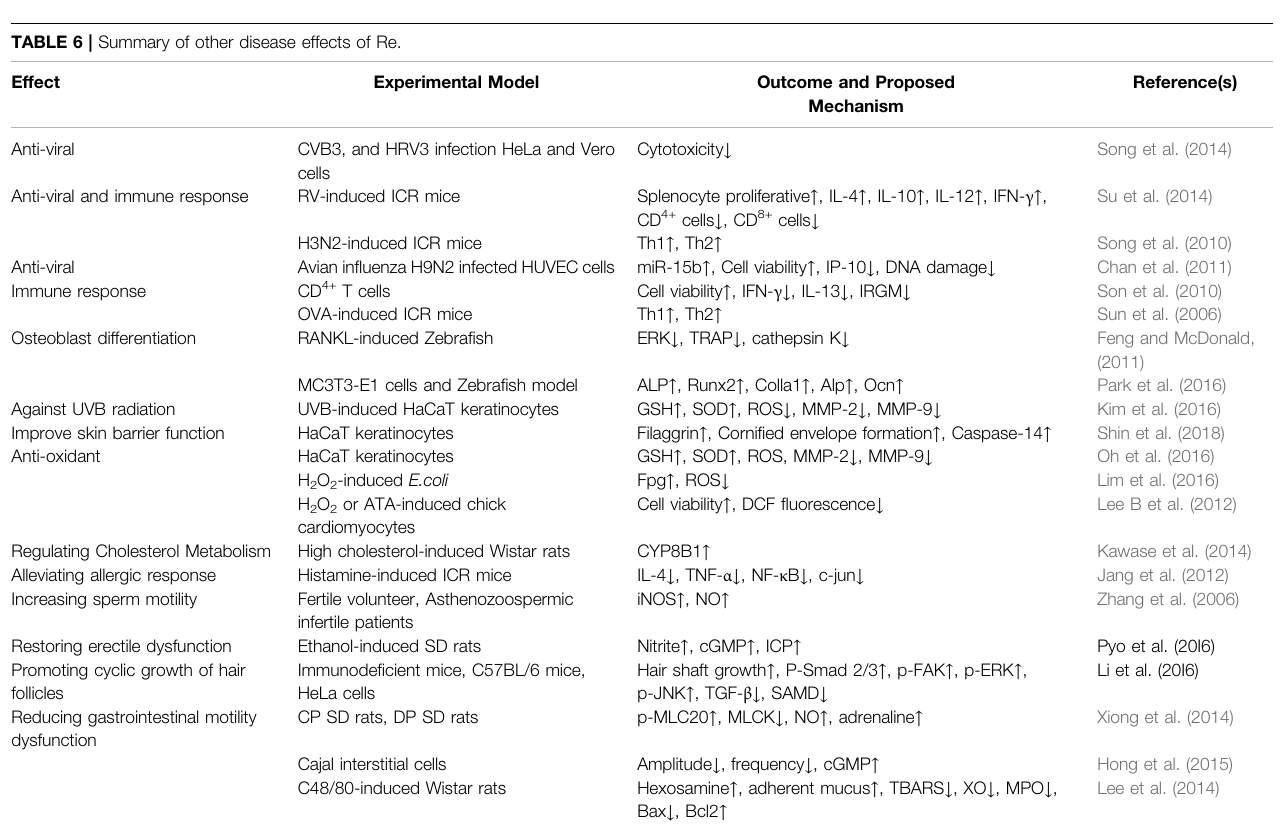
TABLE 6 | Summary of other disease effects of